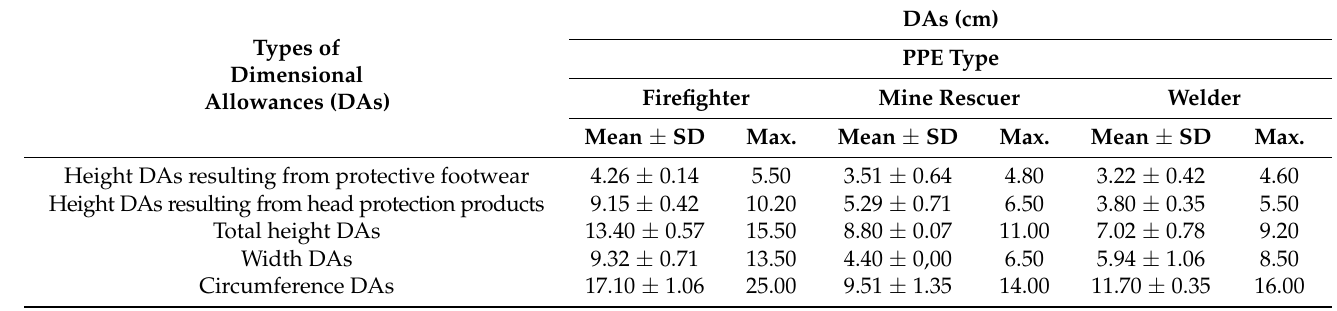
Table 1. Mean and maximum height, width, and circumference dimensional allowances (DAs) for firefighters, mine rescuers, and welders wearing personal protective equipment.